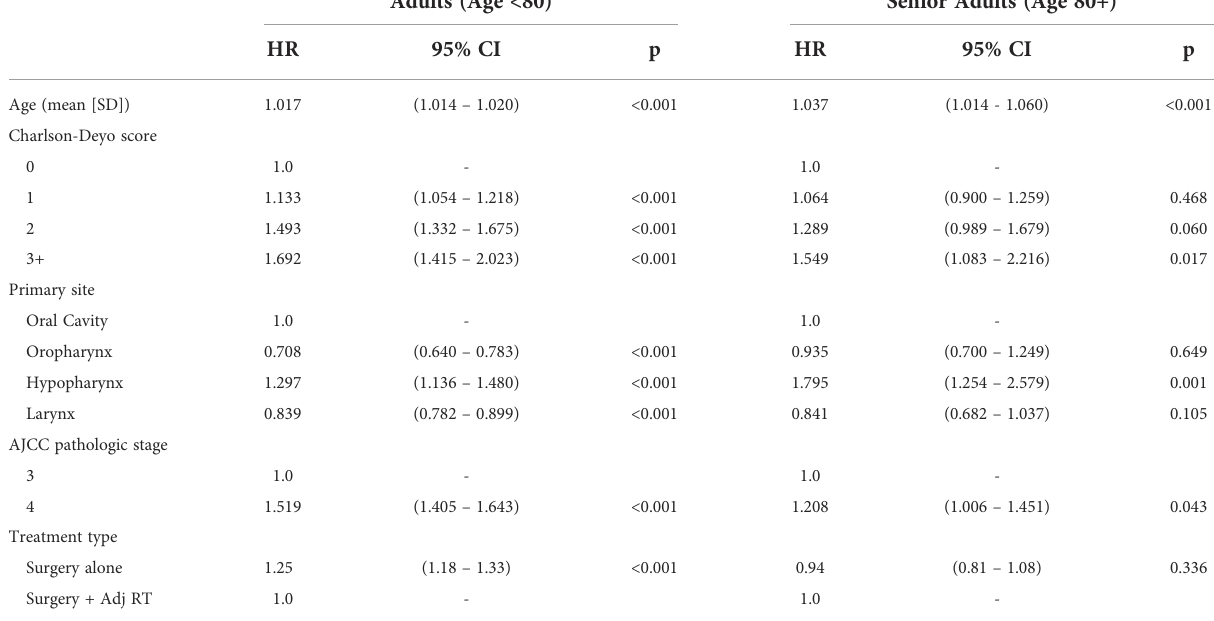
TABLE 5 Cox proportional hazards model for 3-year